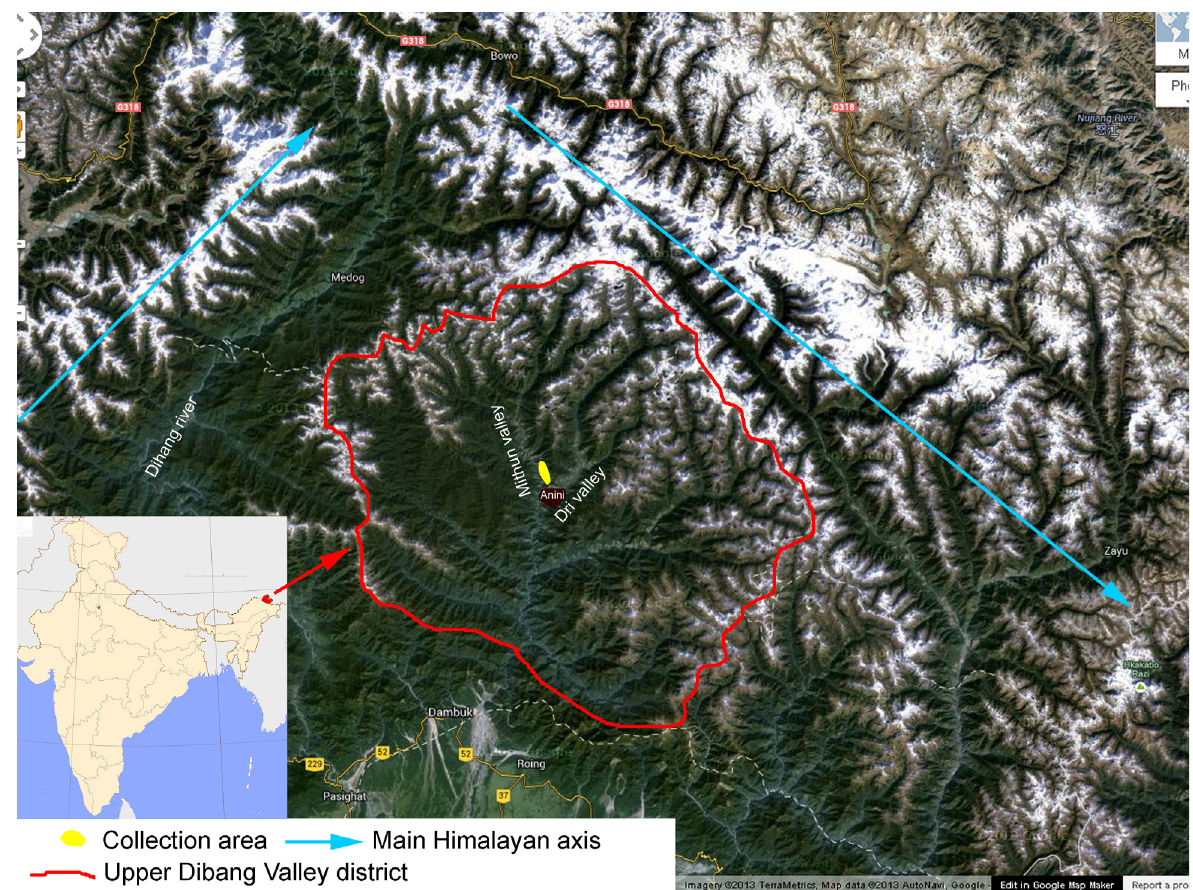
Figure 1. Satellite picture of Upper Dibang Valley